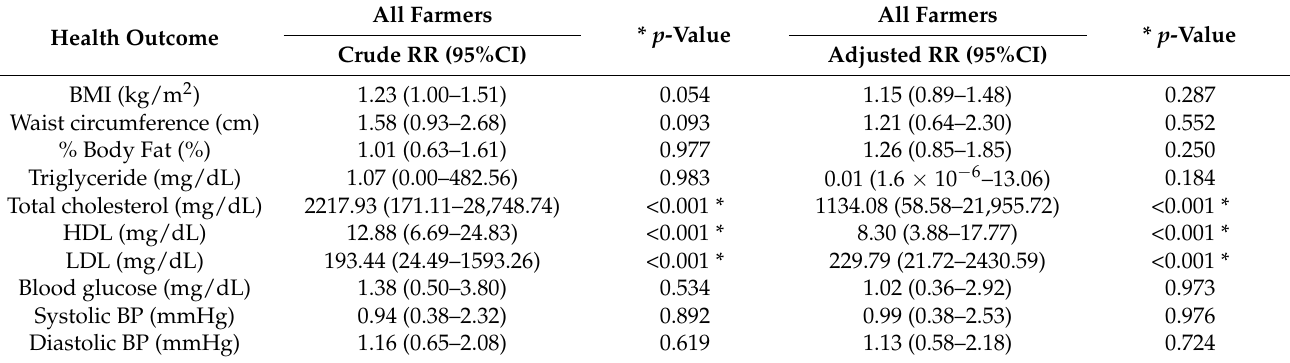
Table 7. Individual generalized linear model models for change in each metabolic biomarker per one unit of Ln DAP. Adjusted models include covariates for age, gender, alcohol consumption, years of pesticide use, living within 1 km of a